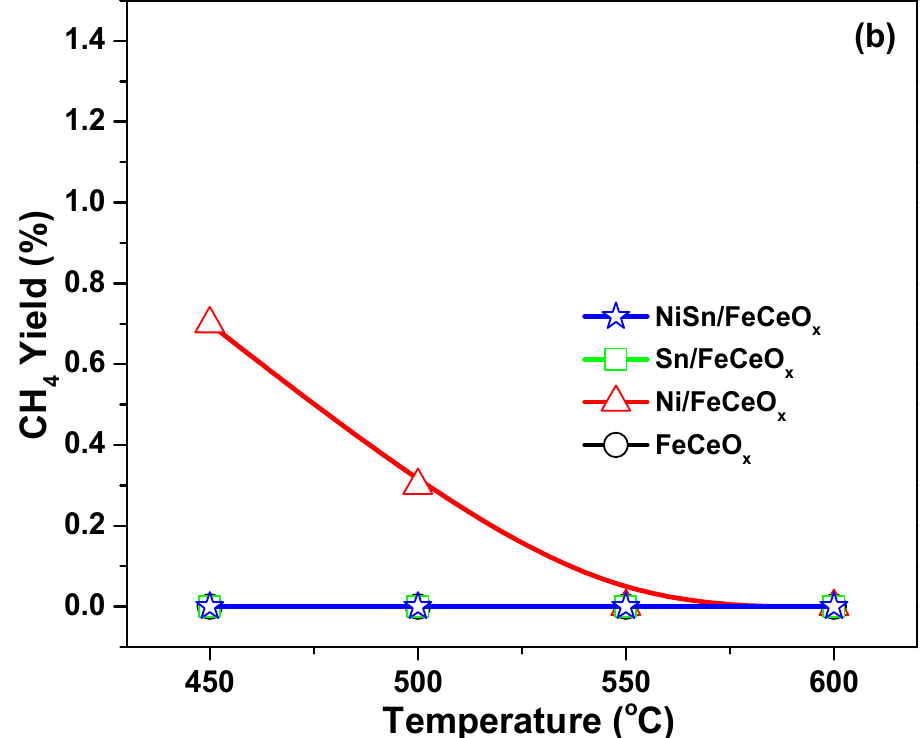
Figure 1. ( a ) High-temperature water–gas shift (HT-WGS) activity and ( b ) methane yield (%) over the FeCeO x , Ni/FeCeO x , Sn/FeCeO x , and NiSn/FeCeO x catalysts at a steam-to-CO ratio of 1.5.